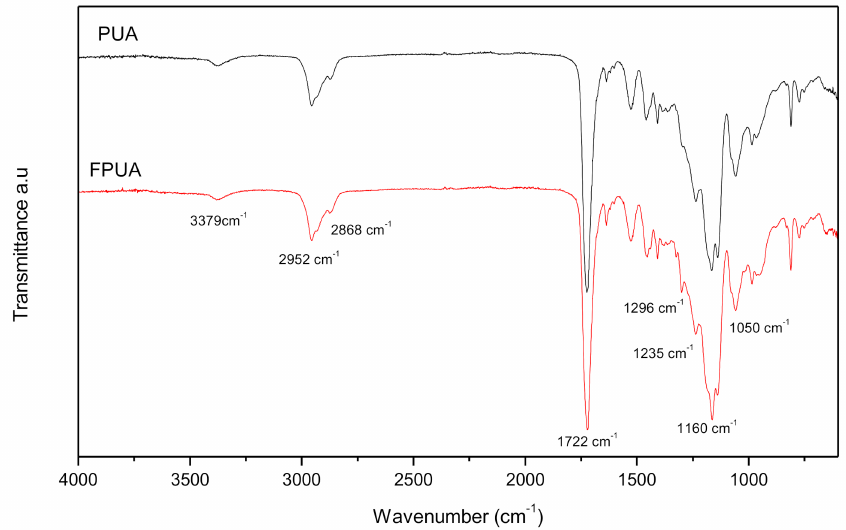
Figure 2. FTIR spectra of the pristine polyurethane acrylate and fluorinated polyurethane acrylate, FPUA-4.